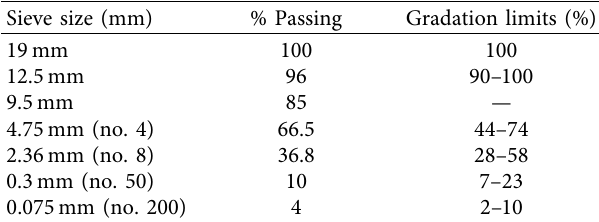
Table 1: Mixture gradations.